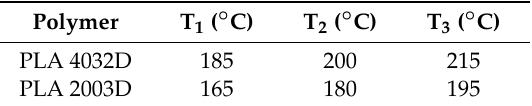
Figure 1. Dog-bone and prismatic specimens dimensions, orientation on the plate, and infill pattern. Table 2. 3D printing temperatures for the two PLA